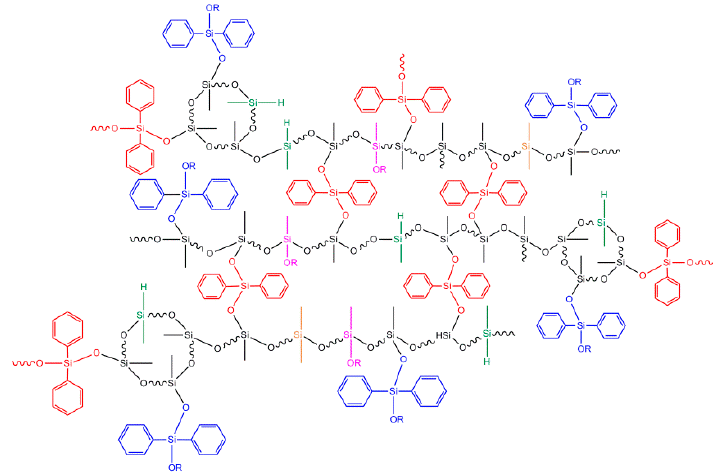
Figure 6. Synthesis of cyclic polysiloxanes by the PR reaction (Reproduced from Reference [32] with the permission).